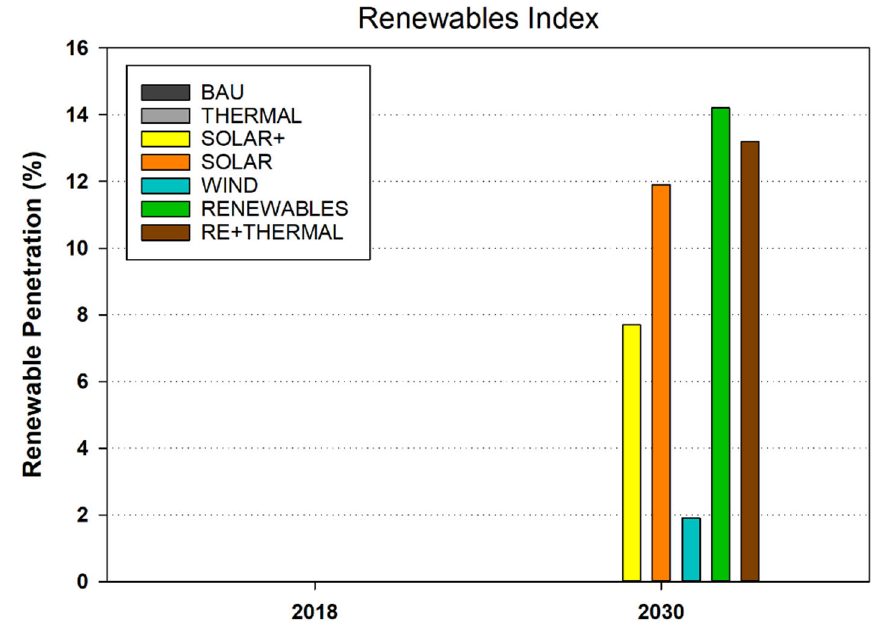
Figure 12. Renewable penetration as renewables index for base and forecast years.